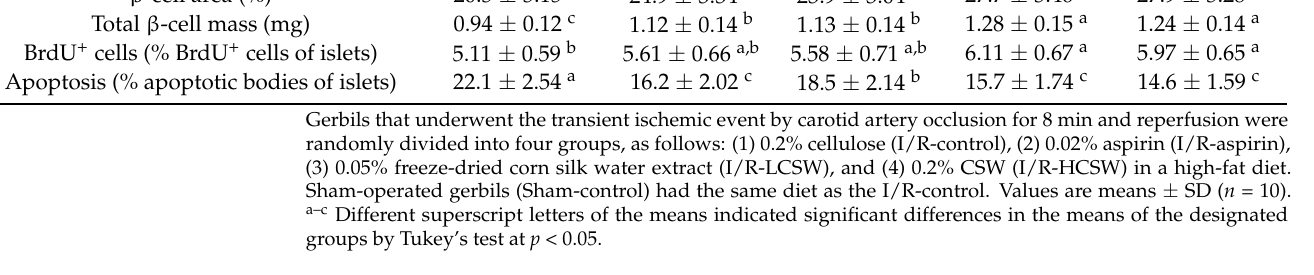
Table 4. Oxidative stress and inflammation